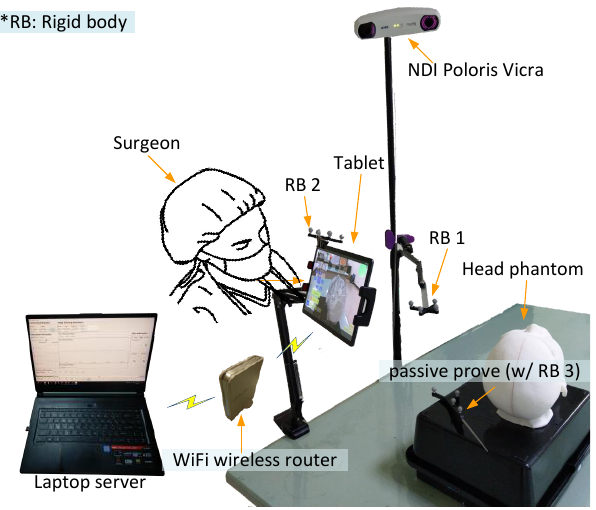
Figure 5. Laboratory simulated clinical trials.